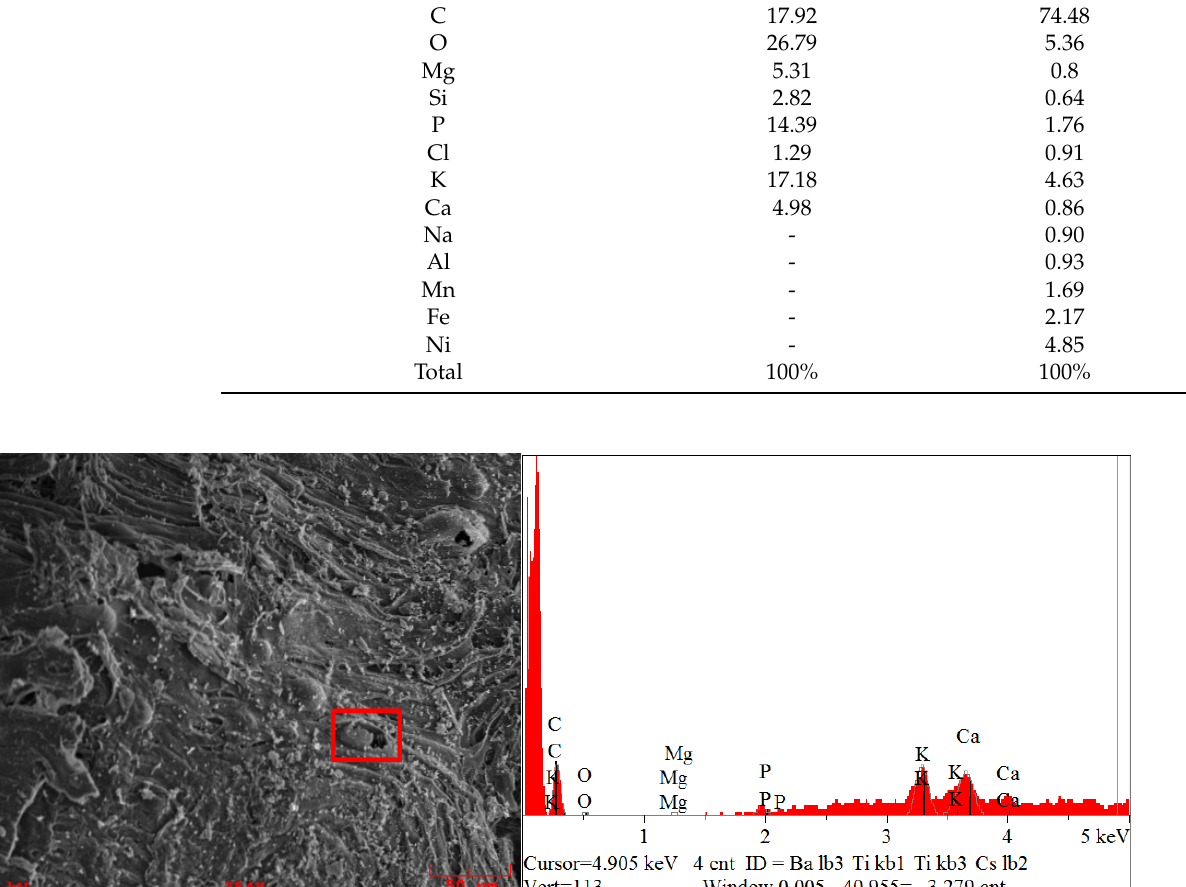
Figure 10. Surface area analysis from inner soybean biochar. Table 6. Element analysis of soybean biochar. Element Concentration wt.%